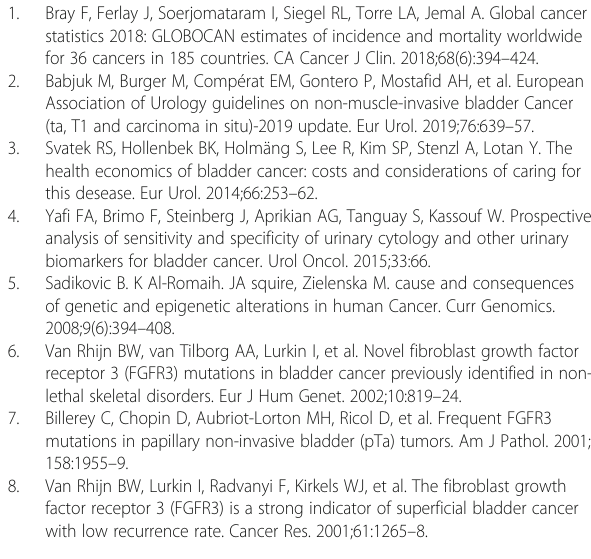
Additional file 1: Figure S1. Construction of mutated FGFR3 plasmids Additional file 2: Figure S2. Melting curve PCR analysis for the FGFR3